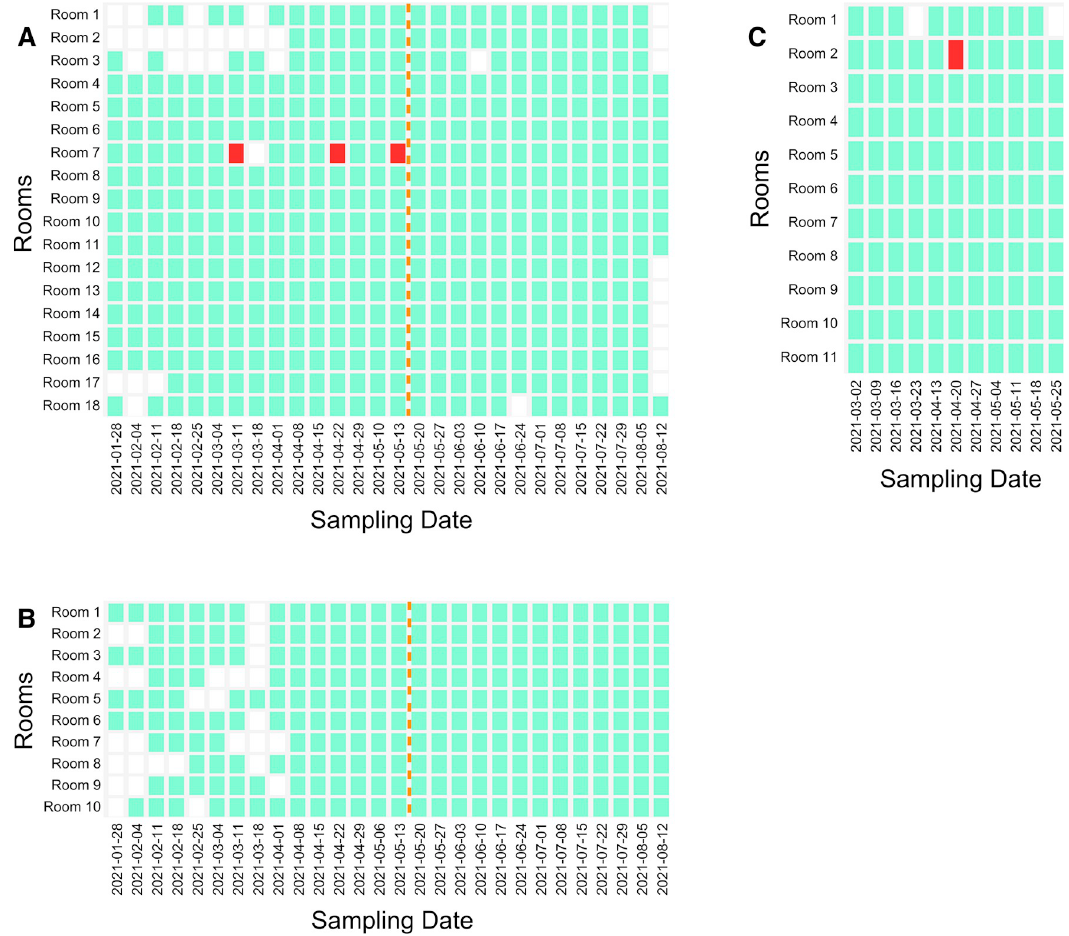
Fig 1. Positive and negative rooms for SARS-CoV-2 based on floor samples collected in (A) School A, ( B ) School B, and ( C ) School C throughout the environmental monitoring study. Episodes with a positive floor sample are marked in red, negative episodes in green, and episodes where no sample was collected are in white. Air filter sampling in Schools A and B started on May 5, 2021 and is denoted by the orange line. No positive air filter samples were